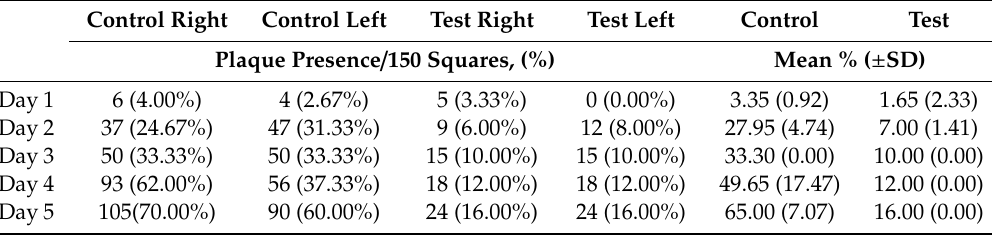
Plaque Table 1 legend: formation on test (implantoplasty) and control implants, as assessed photographically as surface plaque coverage. Table 1. Plaque